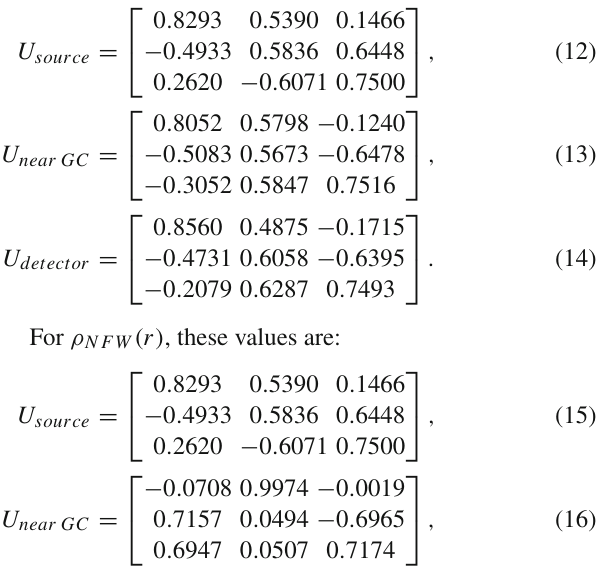
fix the trajectories of the neutrinos so that they pass through the GC, as explained in Penacchioni and Civitarese